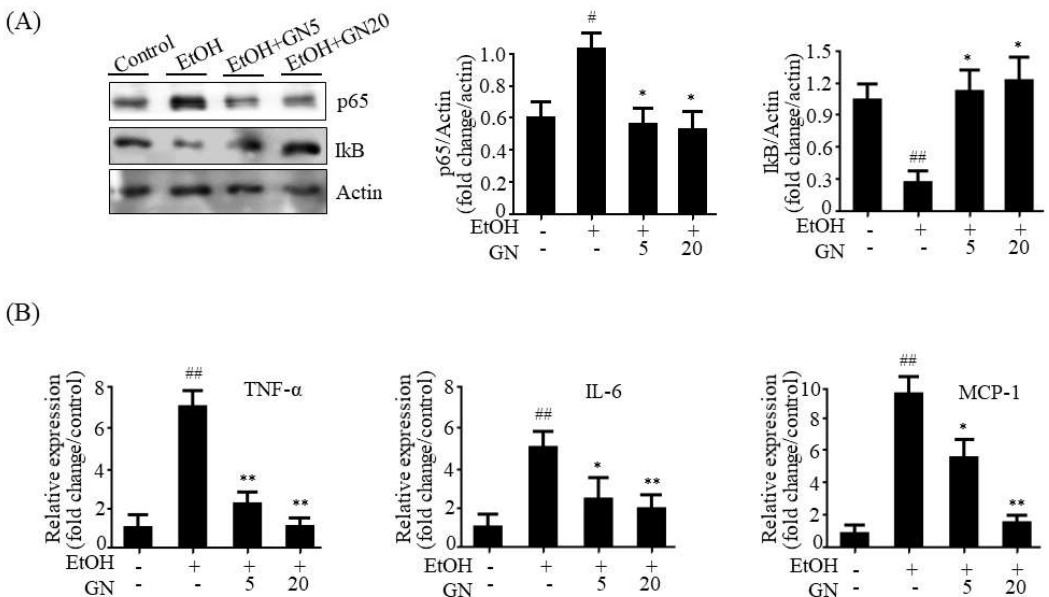
Figure 4. Gomisin N decreases inflammation gene expression by attenuating NF-κB in the liver of chronic-binge ethanol-fed mice. ( A ) Western blot analysis of NF-κB p65 and IκB. Representative images are shown ( left ). Levels of p65 and IκB were quantified by densitometry ( right ). ( B ) qPCR analysis of mTNF-α, mIL-6, and monocyte chemotactic protein-1 (mMCP-1). Values are the mean ± SD ( n = 6). # p < 0.01, ## p < 0.01 vs. pair-fed control mice, * p < 0.05, ** p < 0.01 vs. ethanol-fed mice.